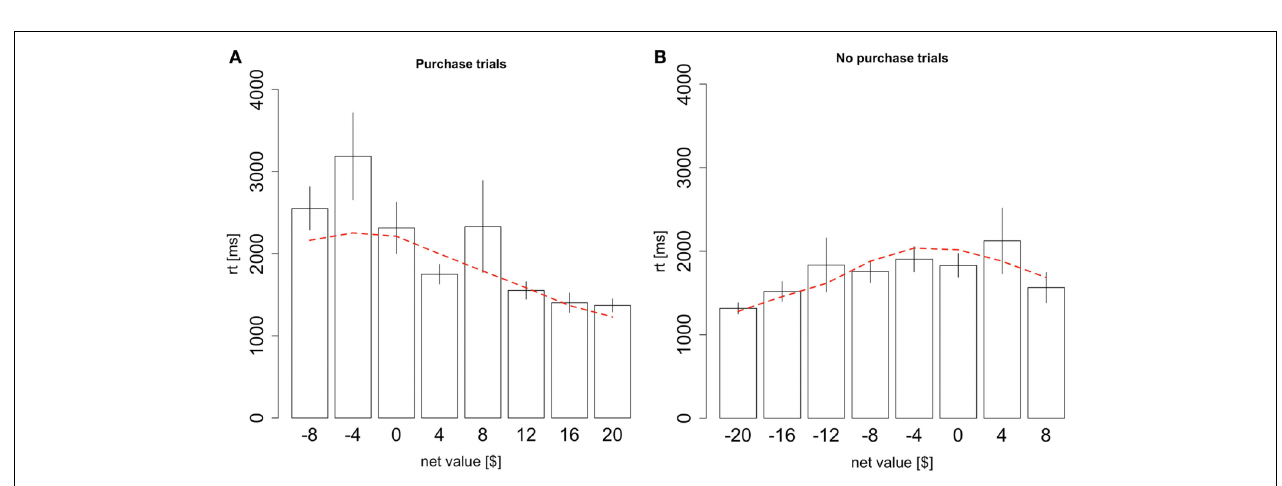
product. Black bars indicate data from the odd-numbered trials of the subject data, and the red dashed lines indicate the simulated data from the aDDM. Bars are standard error bars, clustered by